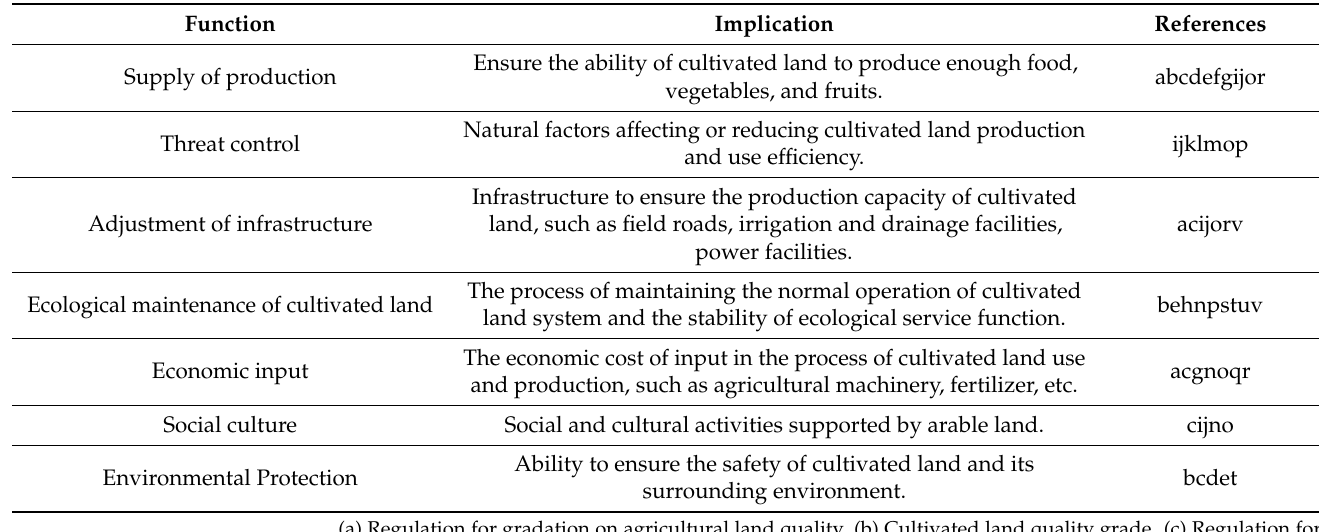
Table 1. Literature review of cultivated land quality evaluation